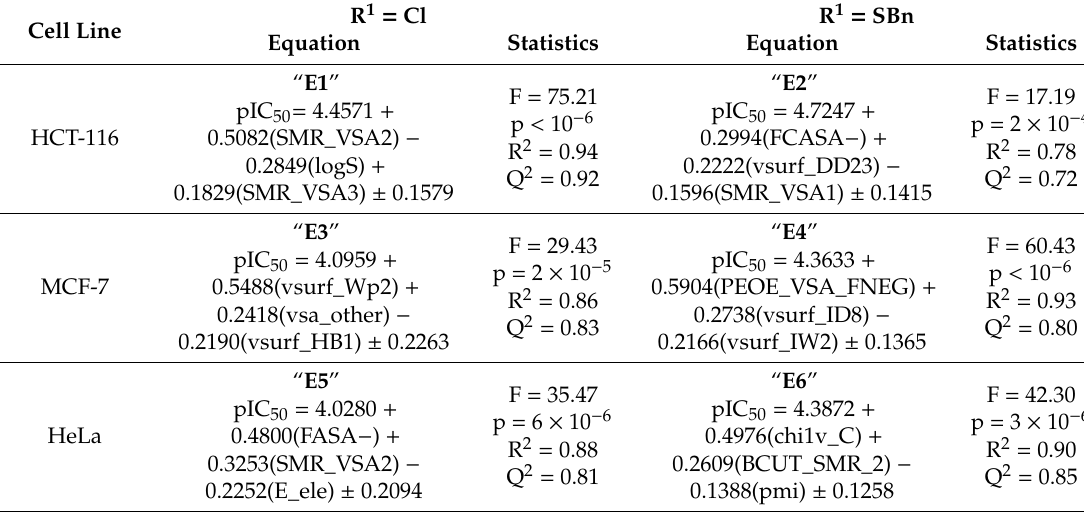
Table 4. The QSAR equations E1 – E6 and their statistical parameters of the two groups of derivatives (R 1 = Cl and R 1 = S Bn) against MCF-7 and HCT-116 cell lines. R 1 = Cl R 1 = SBn Cell Line Equation Statistics Equation Statistics “ E1 ” F = 75.21 pIC 50 = 4.4571 + 0.5082(SMR_VSA2) − HCT-116 0.1829(SMR_VSA3) ± 0.1579